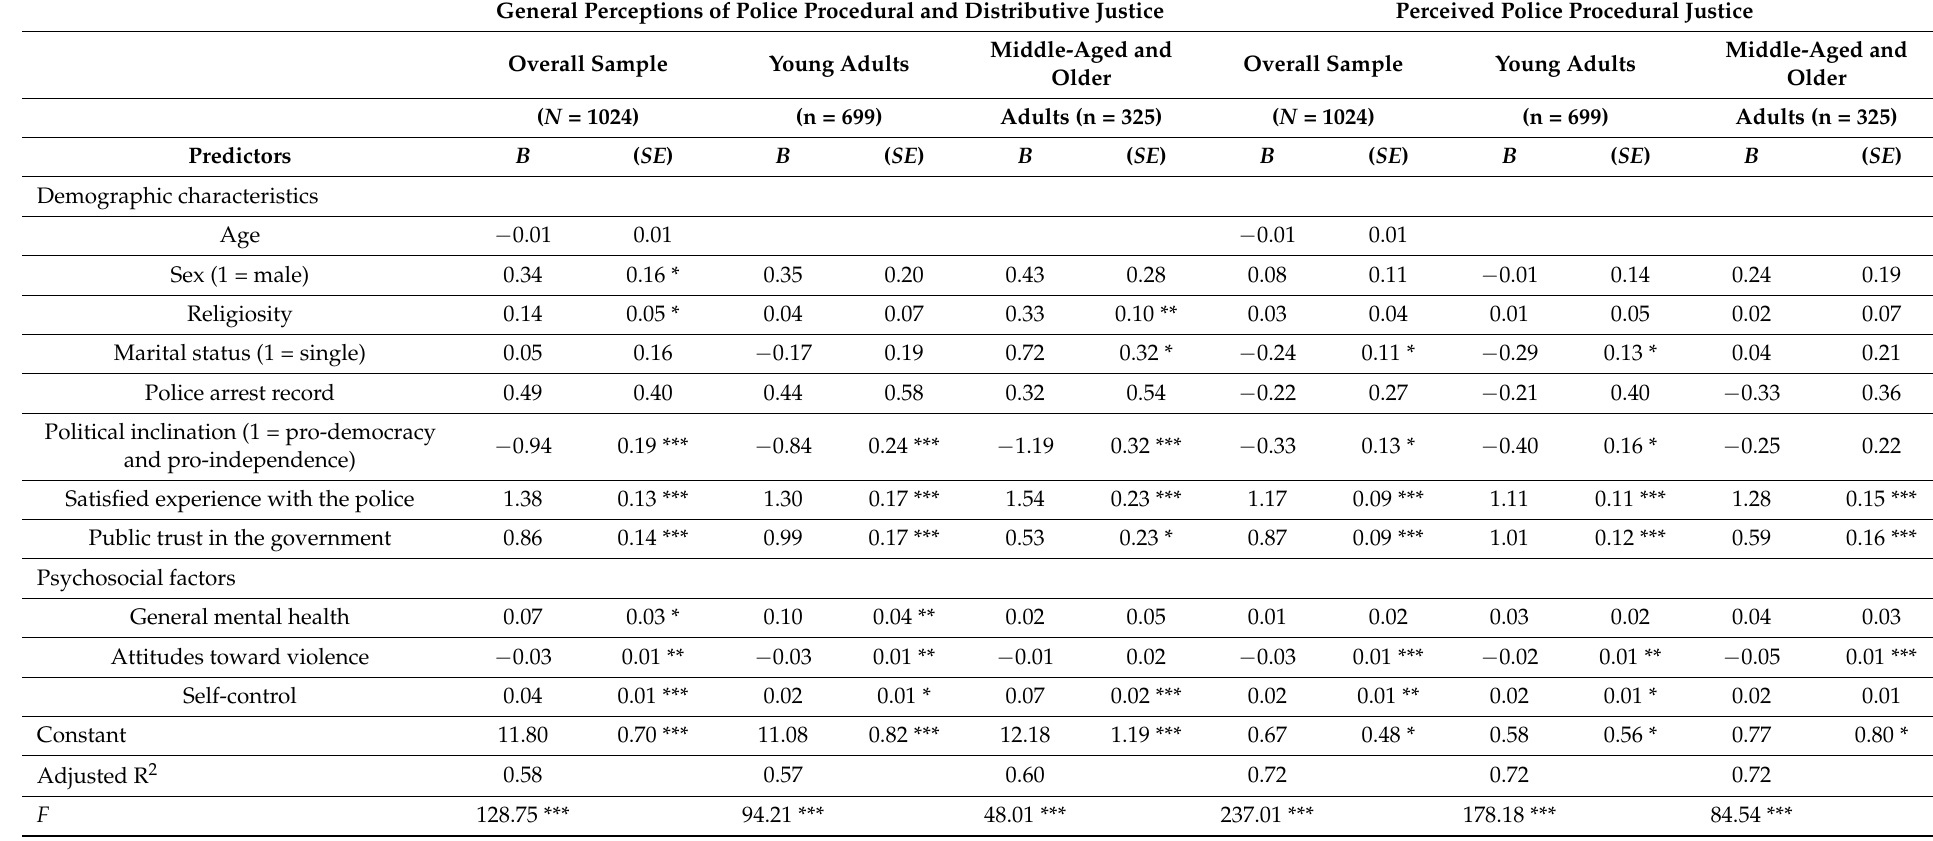
Table 3. OLS regression models of the participants’ perceptions of police procedural and distributive justice. General Perceptions of Police Procedural and Distributive Justice Perceived Police Procedural